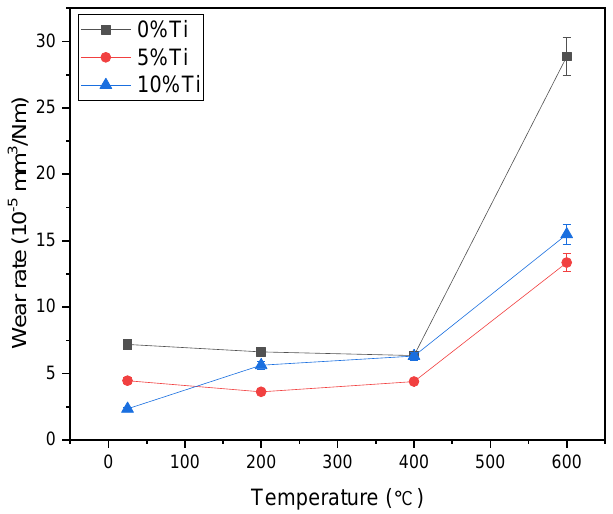
Figure 2. Average friction coefficients of the alloys at different temperatures.